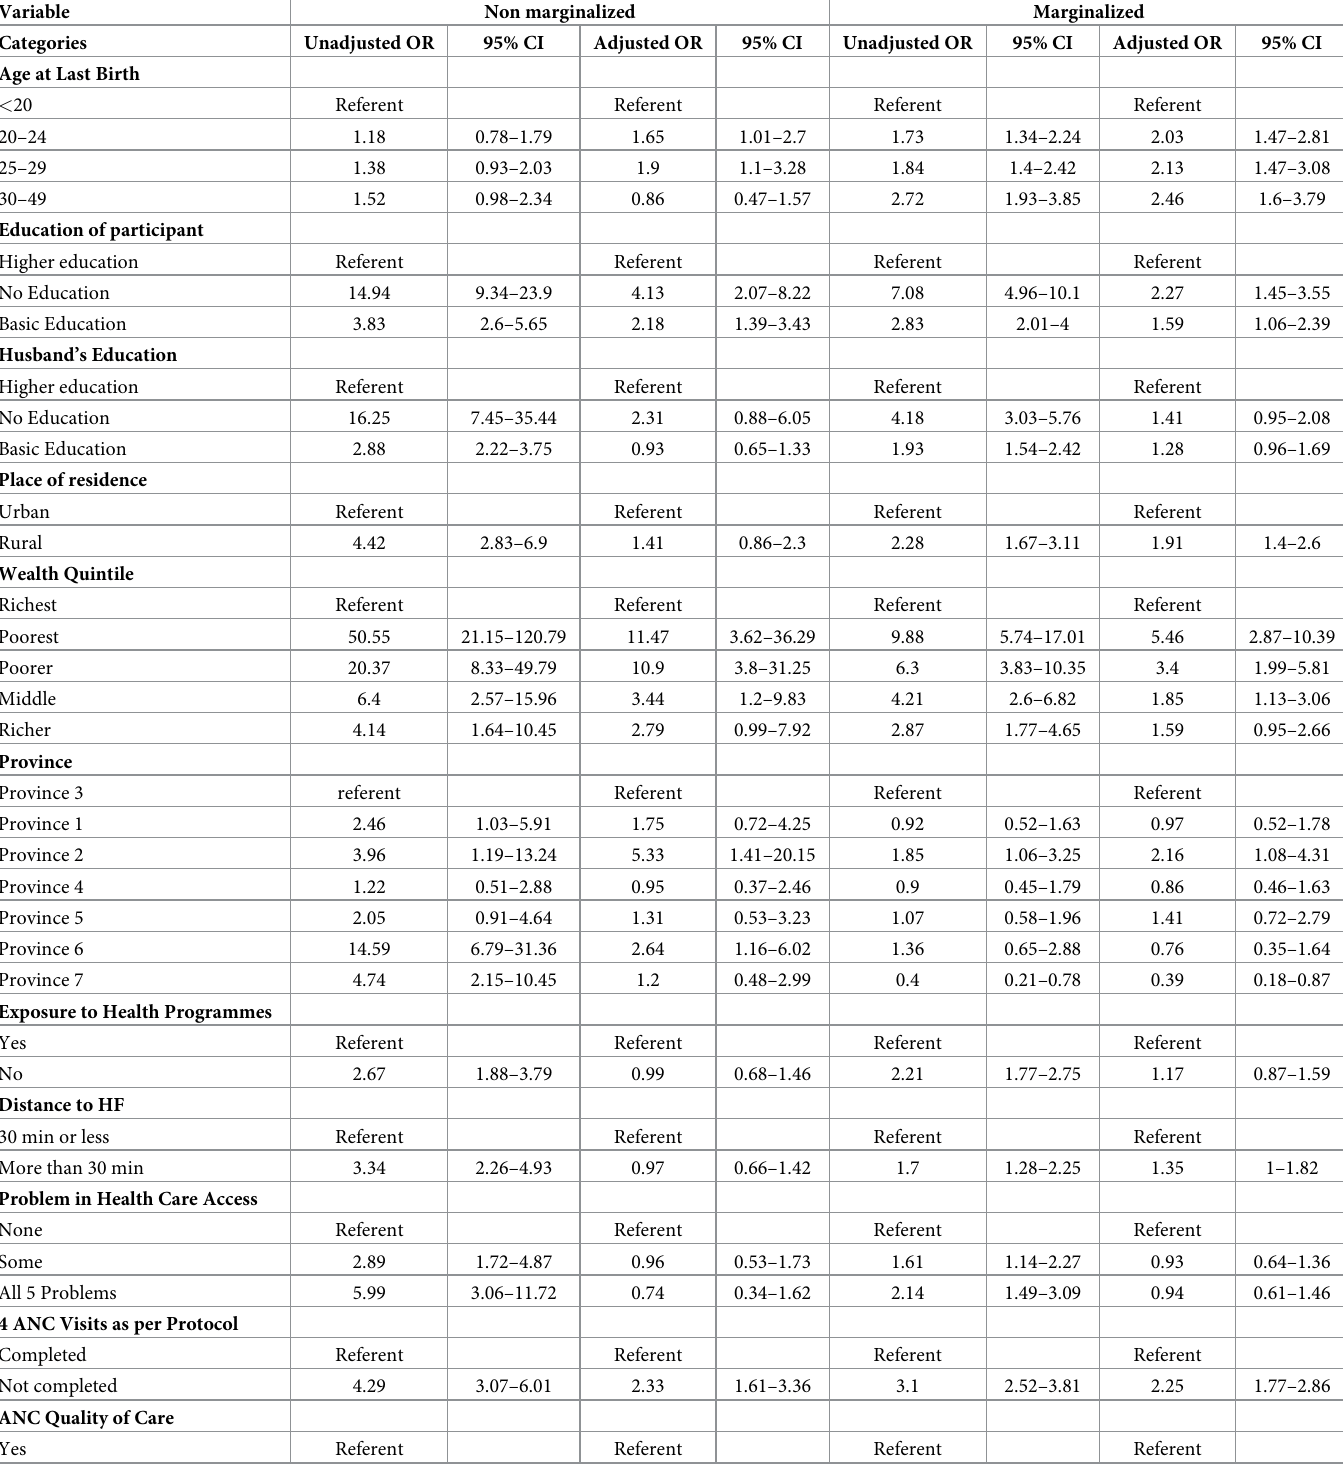
Table 7. Bivariate and multivariable analysis using logistic regression for assessing the factors associated with home delivery among marginalised and non-margin- alised